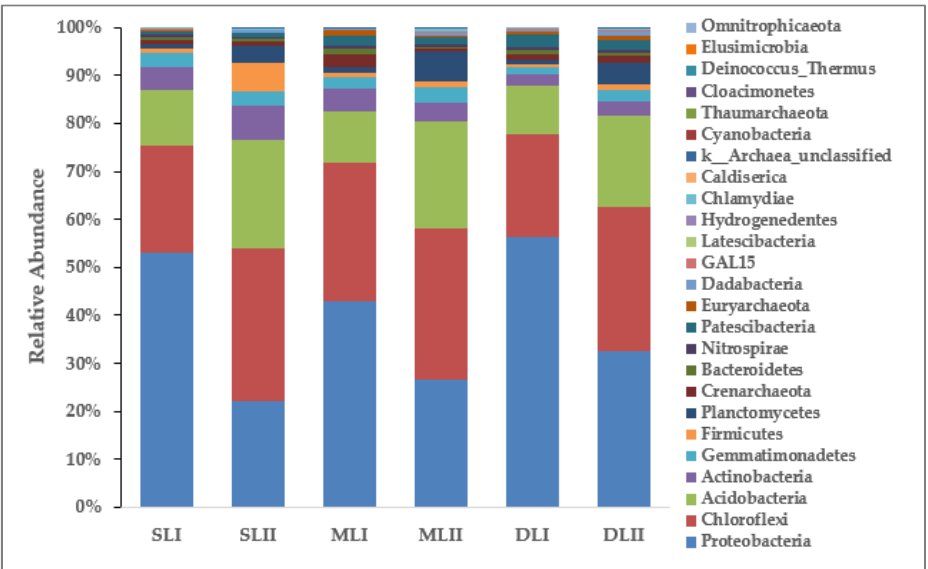
Figure 6. Relative abundance of the bacterial community composition at the phylum in different soil samples.